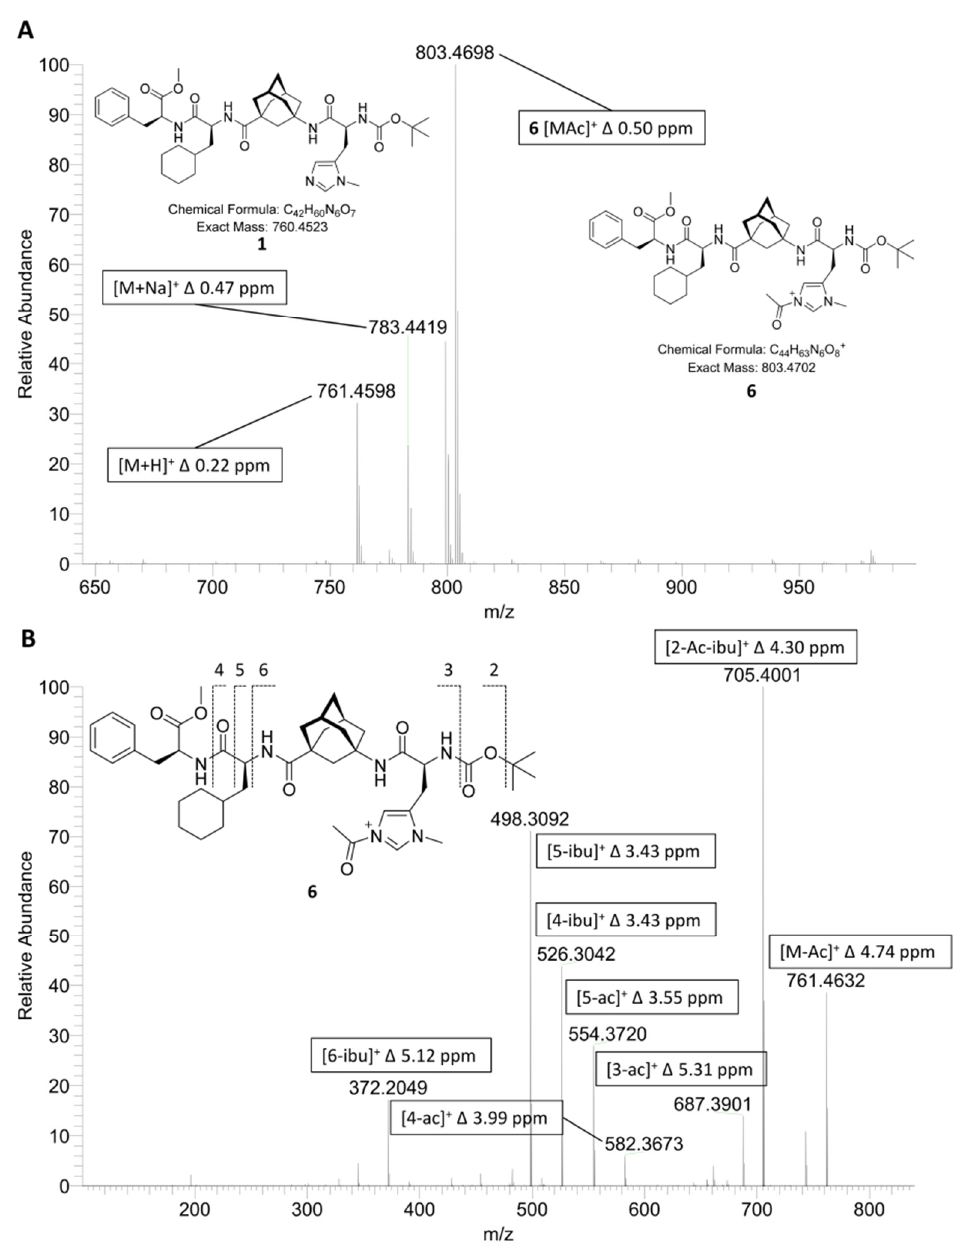
Figure 1. ( A ) Excerpt of full scan positive ion mode (ESI + ) spectrum of a 1 mg/mL solution of tetrapeptide 1 in DCM with 1% anhydride 3 and 1% acetic acid 15 . ( B ) HCD fragment spectrum of the acetylated tetrapeptide 6 with annotated characteristic fragments and their respective mass error.